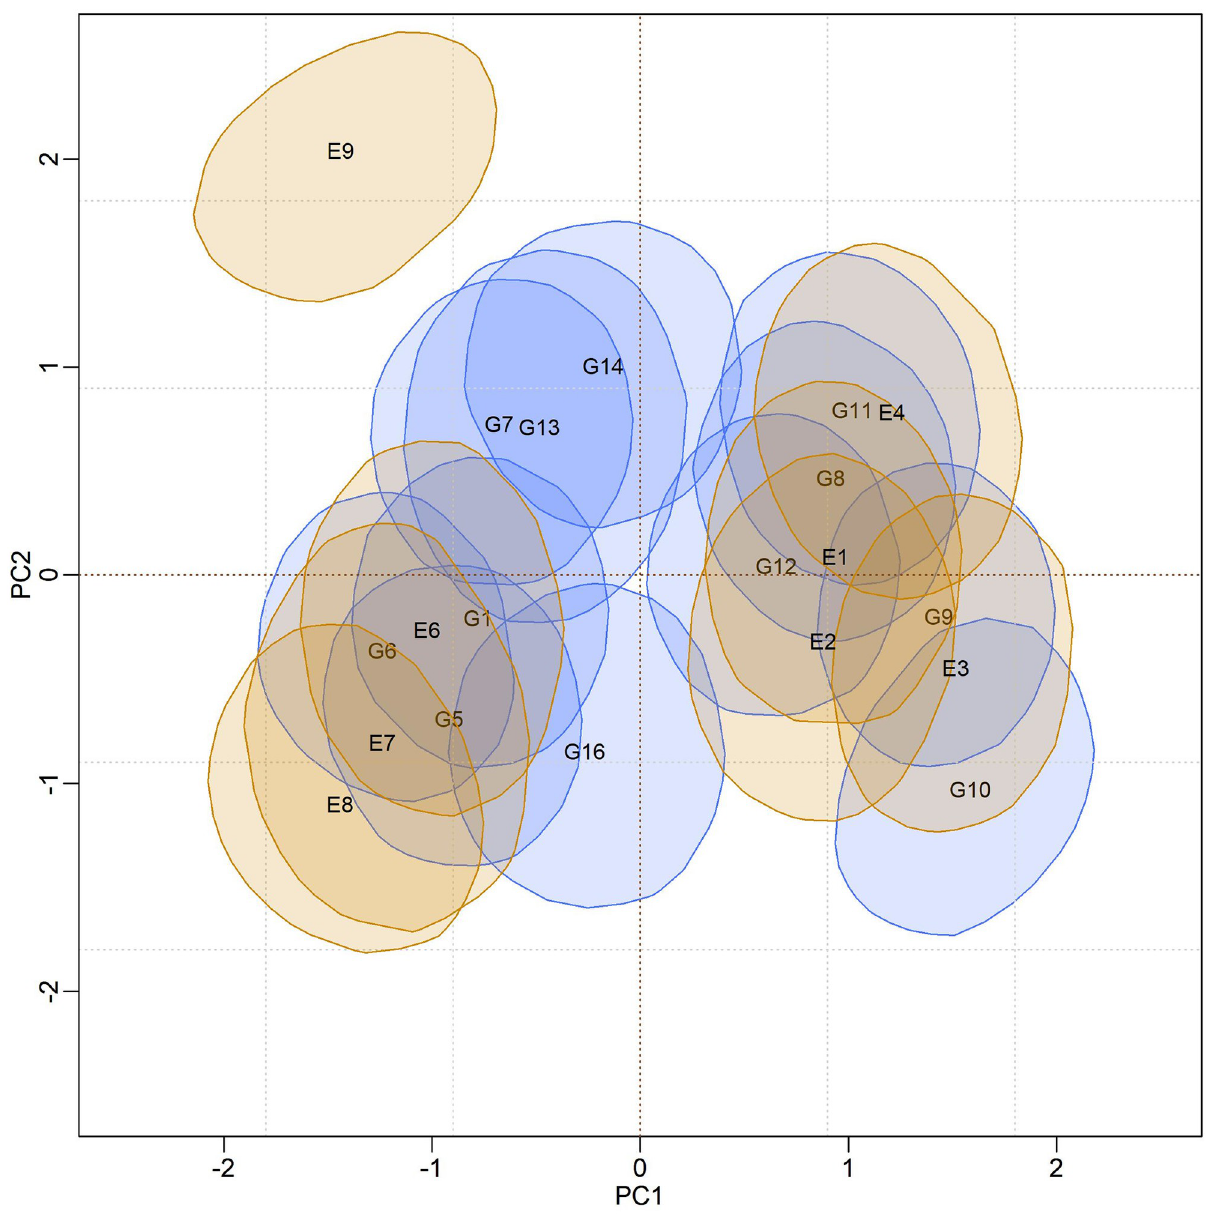
Fig 6. Bivariate credibility regions at 95% probability for the genotypic and environmental scores of the BAMMIS model whose regions do not contain the origin